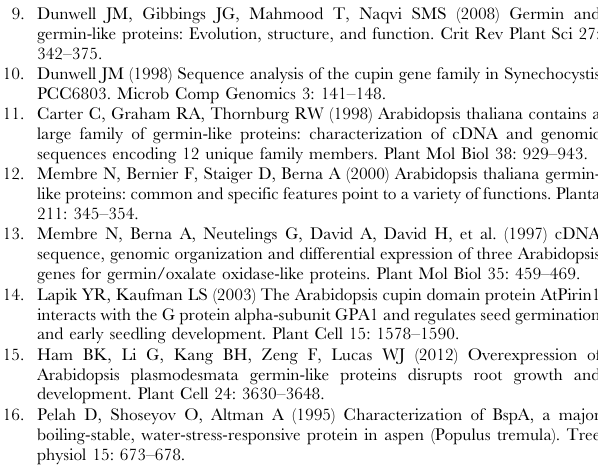
Table S1 Pairwise identities between homologous pairs of Cupin genes from